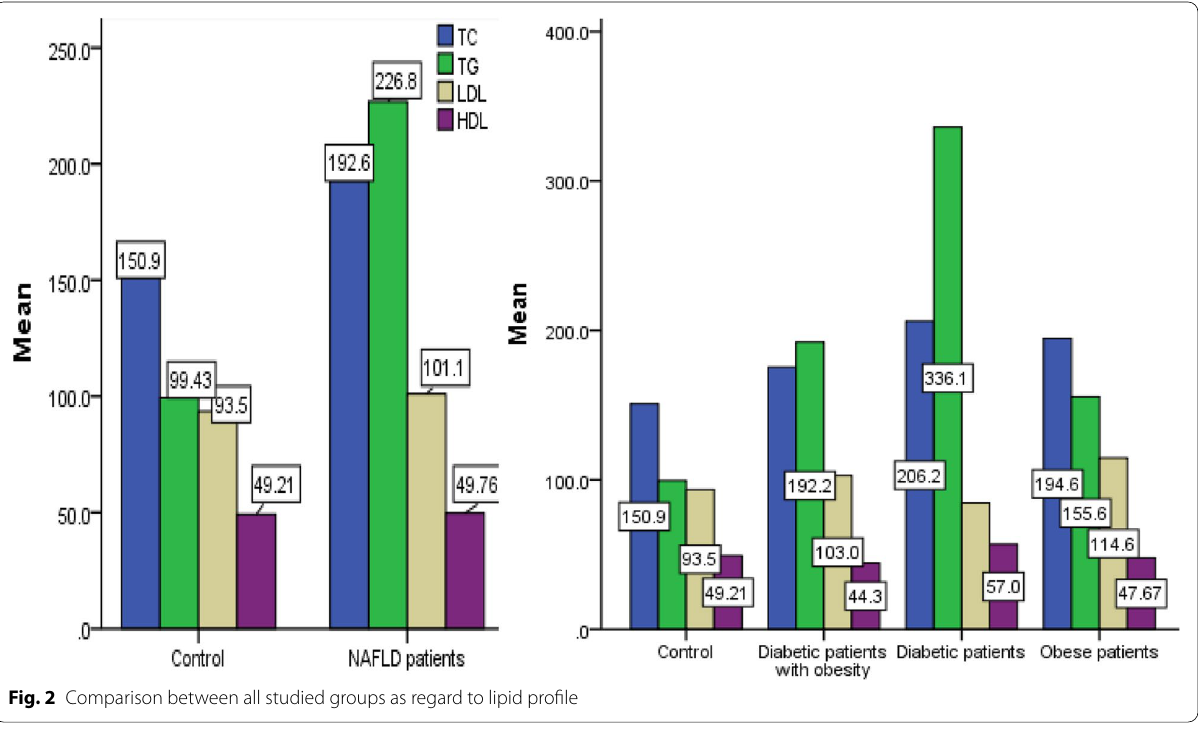
Fig. 2 Comparison between all studied groups as regard to lipid profile